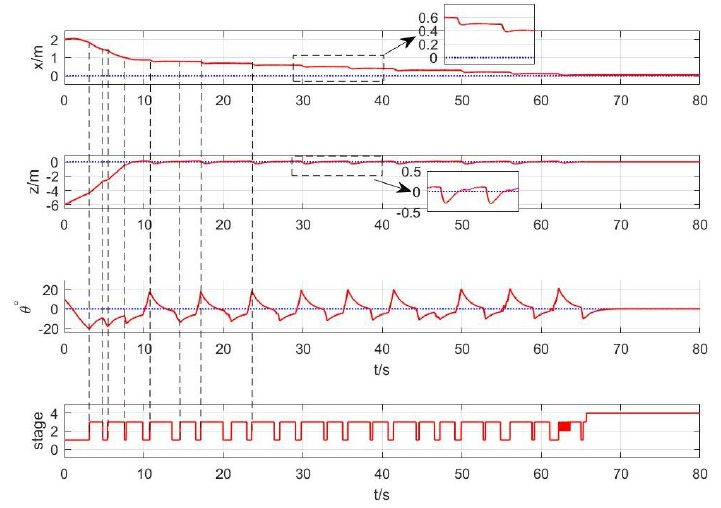
Figure 7. Simulation of the initial poseture X 0 = [ 2, − 6,10 ◦ ] T : Evolution of the mobile robot pose and the stage